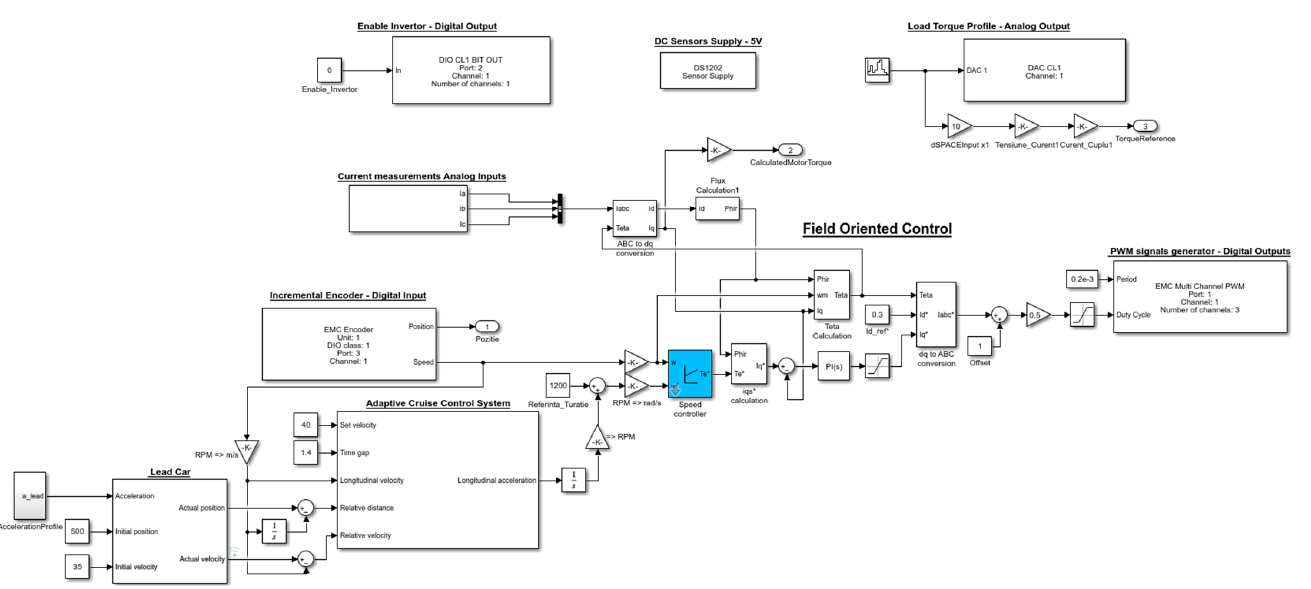
Figure 15. Simulink implementation of the control block used to program dSPACE platform.